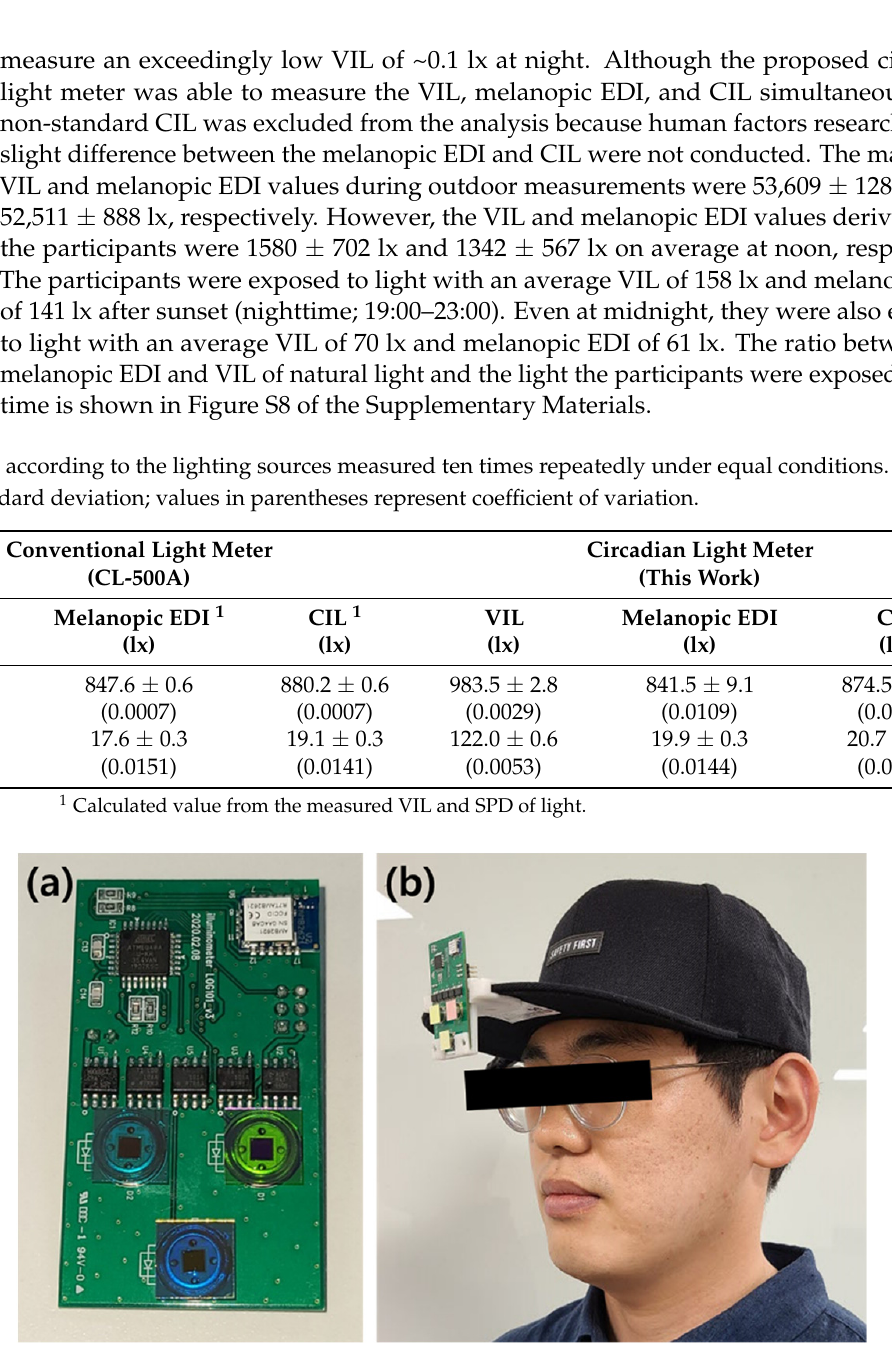
Figure 4. ( a ) Photograph of the fabricated circadian light meter. The circadian light meter consists of three photodiodes with different filters attached (upper left: Mel-filter, upper right: V-filter, and lower: C-filter). ( b ) Photograph of a participant wearing the hat with the circadian light meter. The circadian light meter was attached to the hat visor through a parts output from a 3D printer.